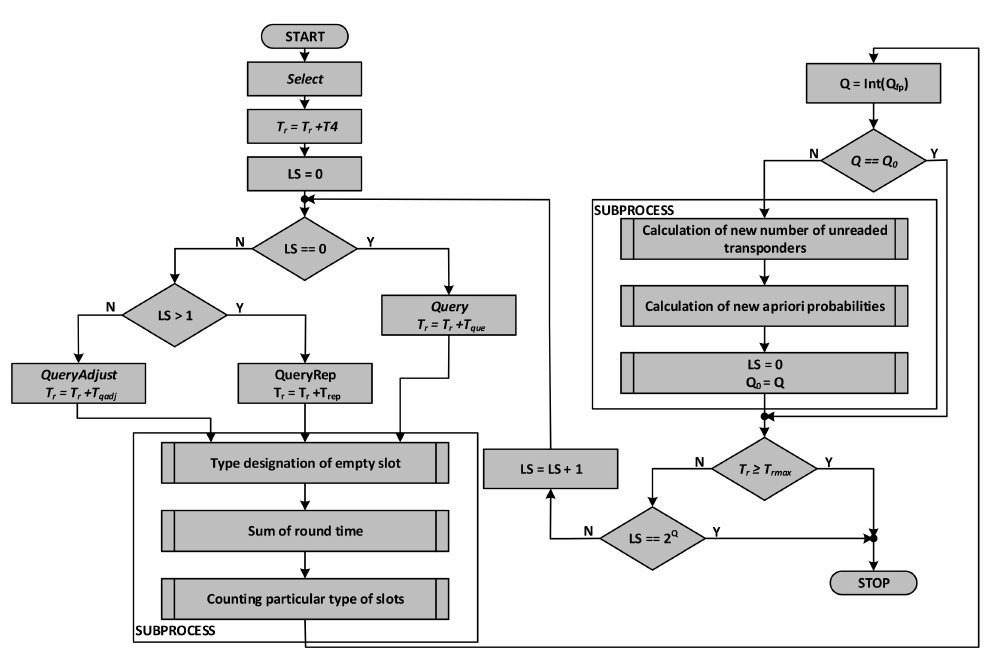
Figure 12. Algorithm for simulation a single inventory